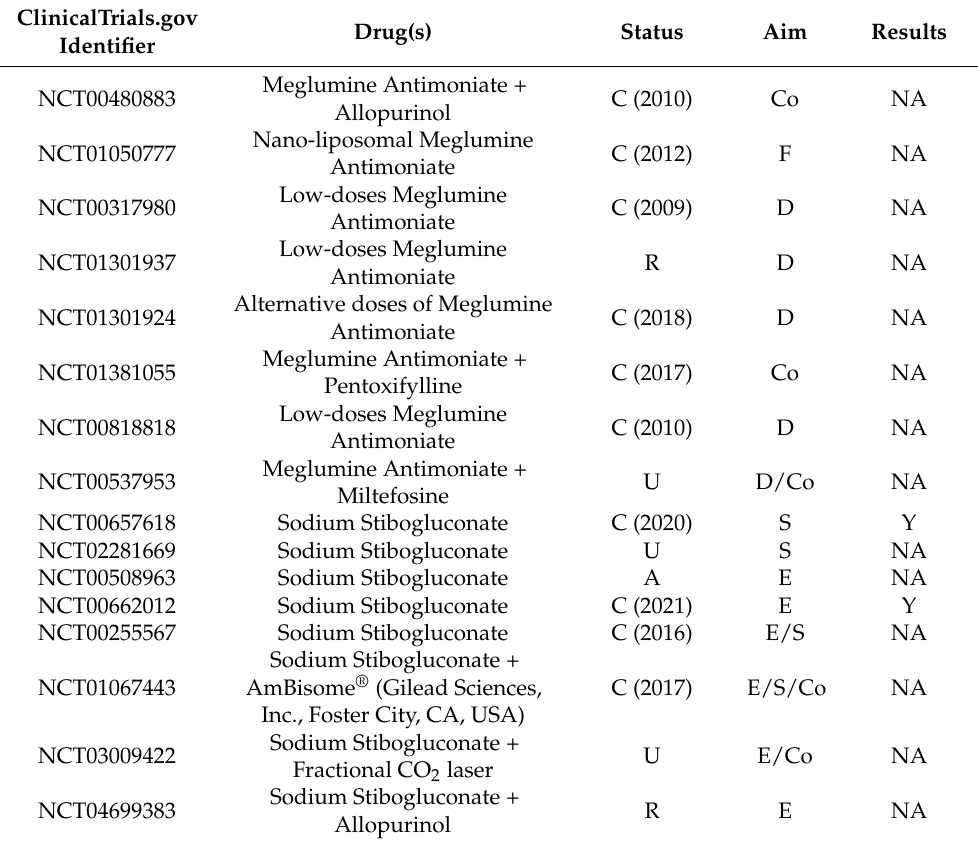
Table 3. Clinical trials involving sodium meglumine antimoniate and stibogluconate as anti- leishmaniasis agents (from https://clinicaltrials.gov/, accessed on 27 April 2021).